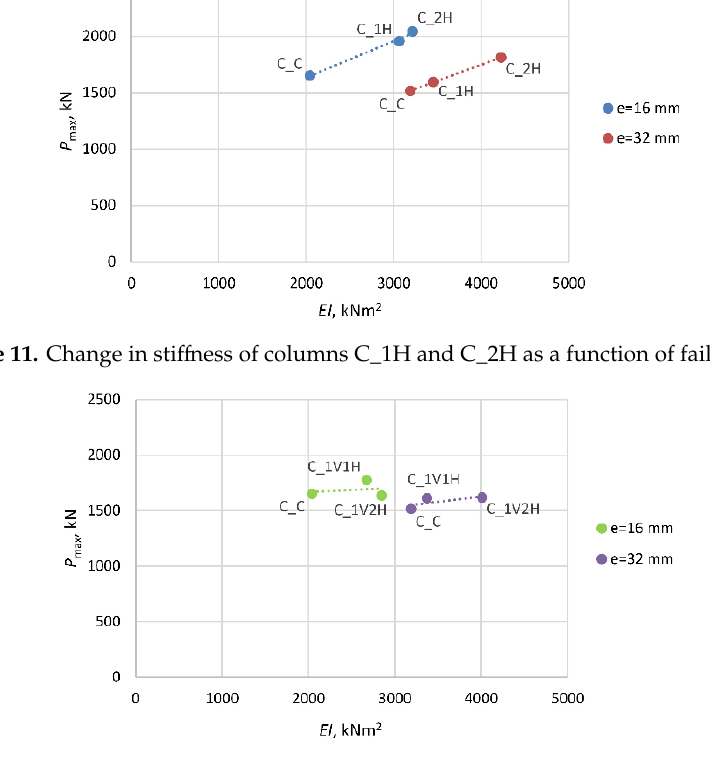
Figure 12. Change in stiffness of columns C_1V1H and C_1V2H as a function of failure load.